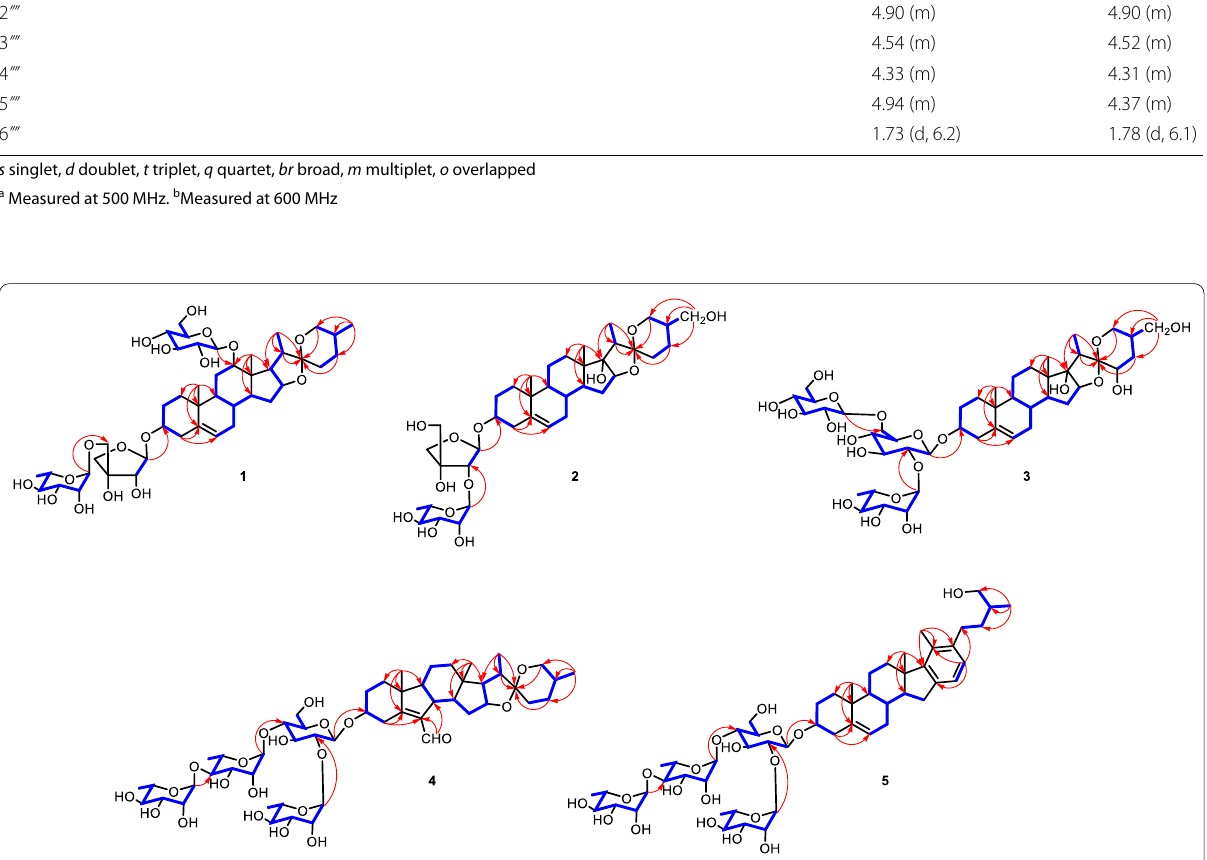
Fig. 2 1 H ‒ 1 H COSY and Key HMBC correlations of 1 ‒